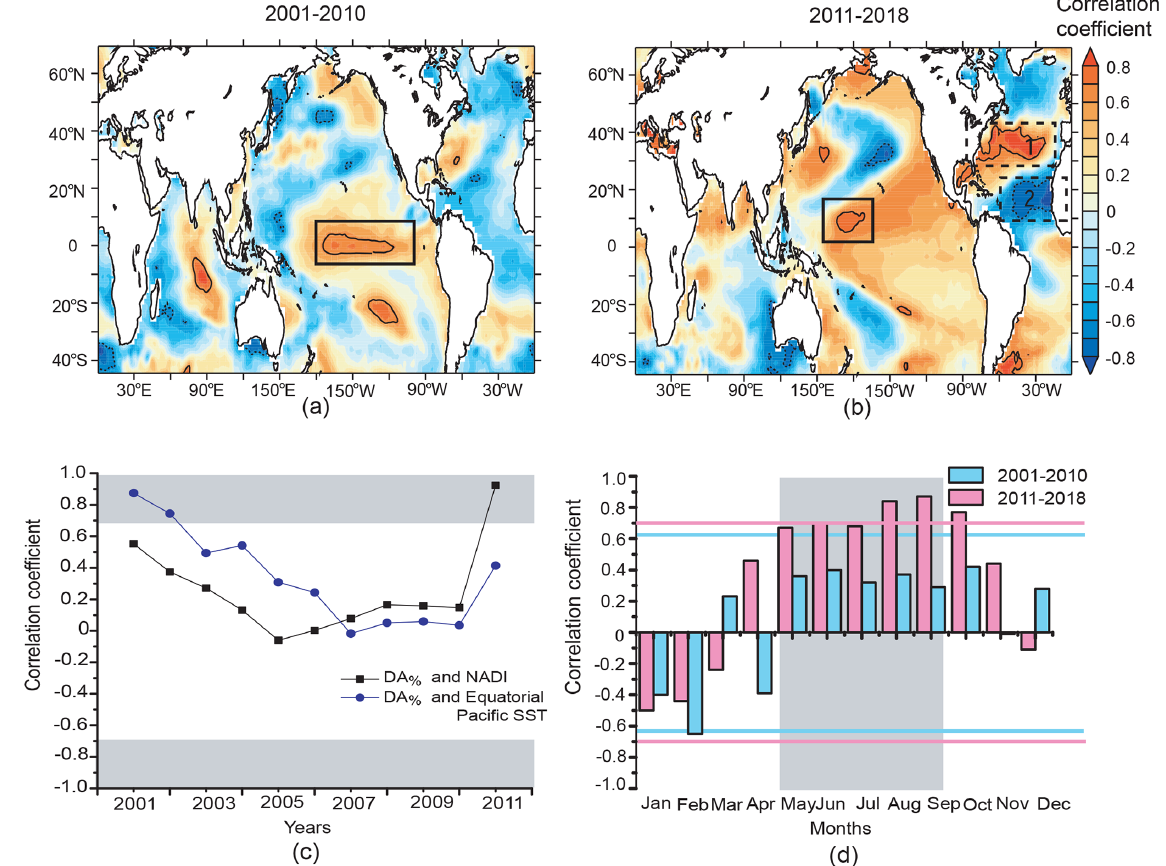
Figure 4. Correlation between the percentage frequency of annual dust activity (DA % ) and the annual average SST for (a) 2001–2010 and (b) 2011–2018. The black contours enclose the regions where the correlation coefficient is significant at the 95% confidence level. The solid (dashed) boxes show the main regions where DA % over South Asia has significant correlations over the Pacific (Atlantic) Ocean (see text for details). In panel (b) , the regions used for constructing the North Atlantic difference index (NADI) are marked as “1” and “2”. (c) The 8-year running correlation between DA % and the April–June NADI (black curve) and between DA % and the September–October central equatorial Pacific SST (blue curve). The x axis shows the first year for each correlation window, and the gray shaded regions mark the 95% significance level. (d) Correlation between the April–June NADI and monthly DA % are plotted. The blue and pink horizontal lines indicate the 95% confidence levels for 2001–2010 and 2011–2018, respectively. The gray shaded region highlights the months that have DA % values greater than the annual average DA %